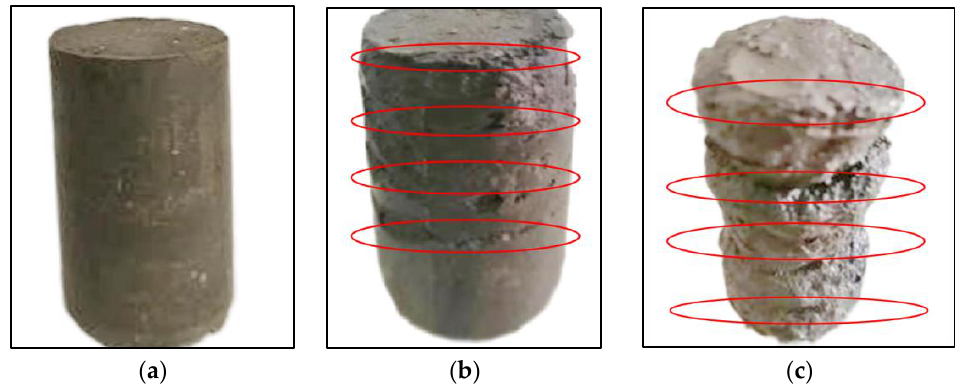
Figure 23. Morphology of the solidified silt with a w g of 2% during dry-wet cycles: ( a ) N dw = 0, ( b ) N dw = 1.